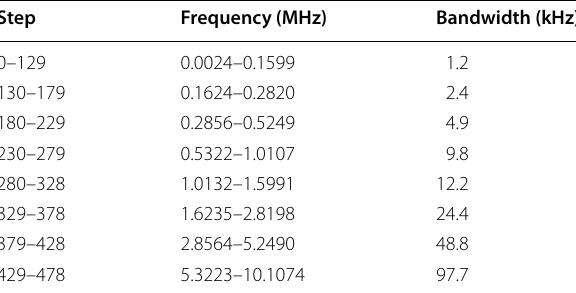
Table 2 Frequency table of downlinked spectrum